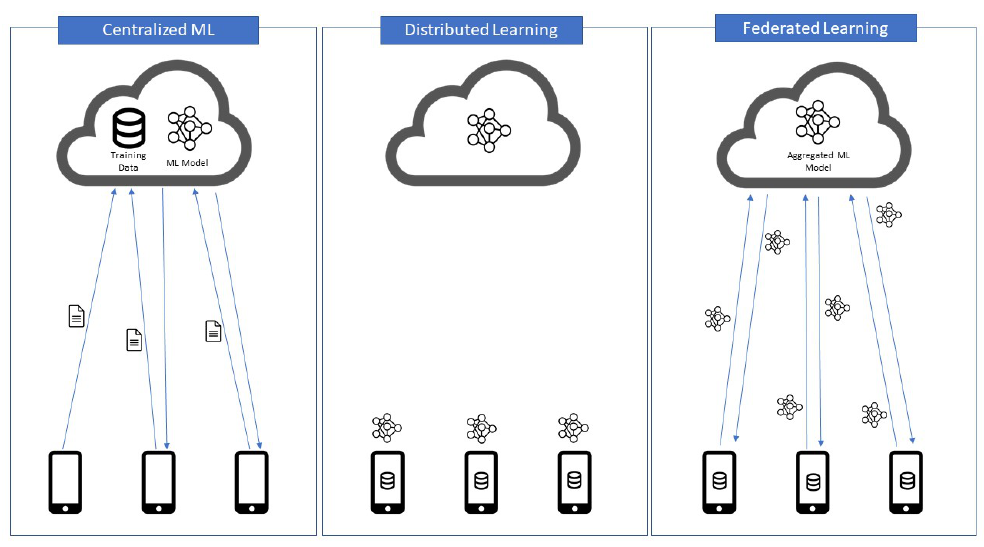
Figure 1. Federated Learning Applications.